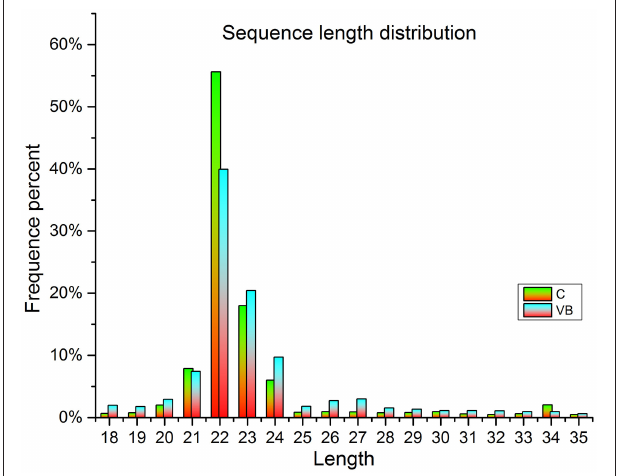
FIGURE 4 | The length distribution of sequenced miRNAs in C (control) and VB.